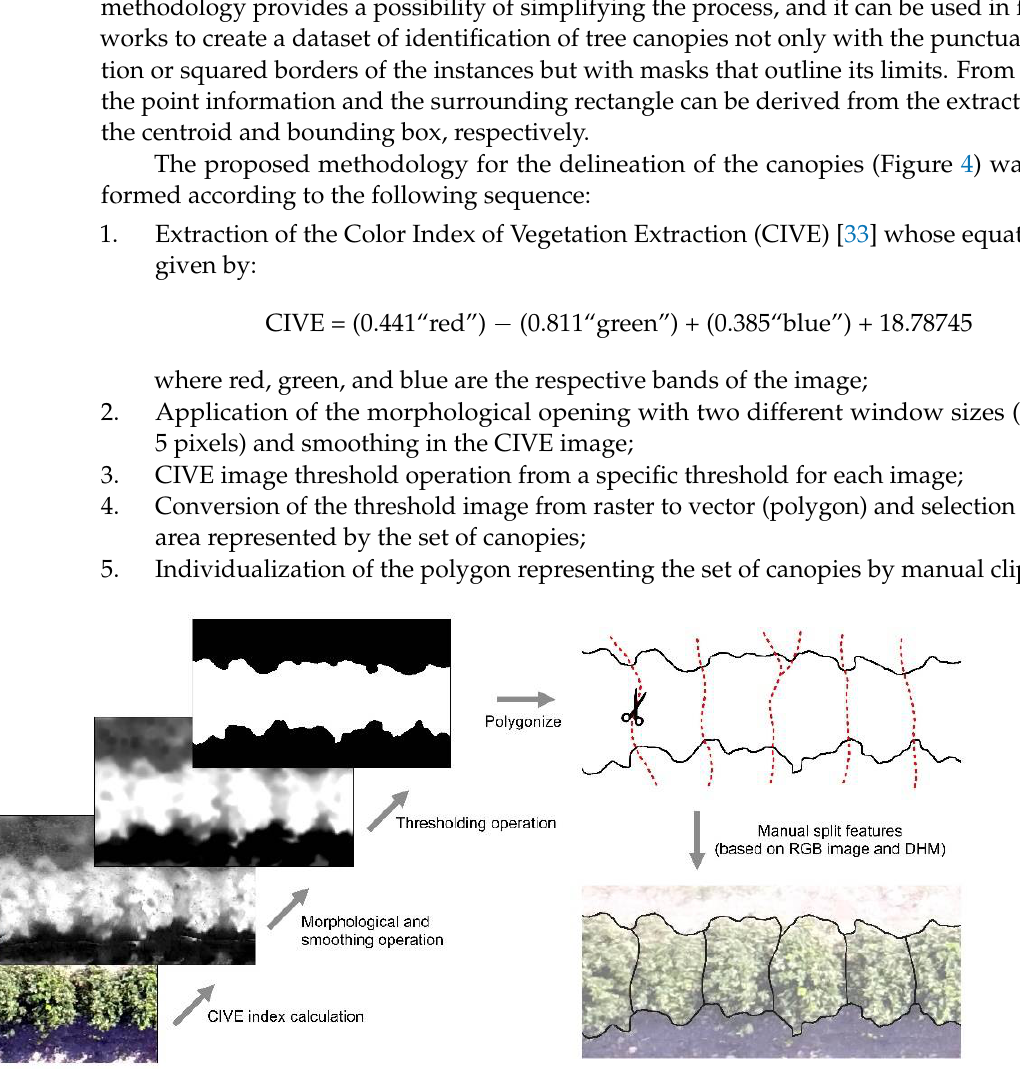
Figure 4. Framework of process adopted for crown delimitation.